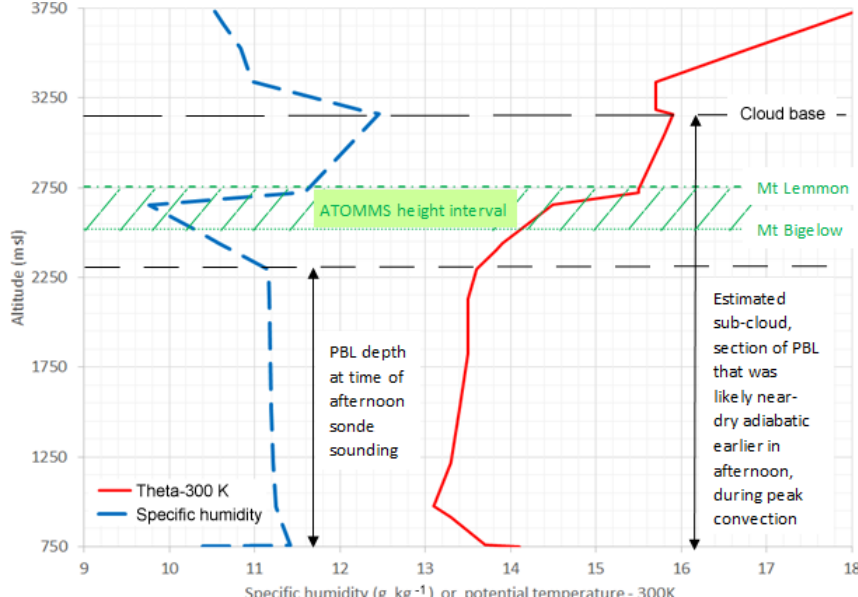
Figure 9. Vertical profiles of specific humidity and potential temperature minus 300K calculated from the 00:00UTC Tucson sonde. The local time of the sonde launch was approximately 16:30 on 18 August. Theta label for the red line stands for potential temperature and PBL stands for planetary boundary